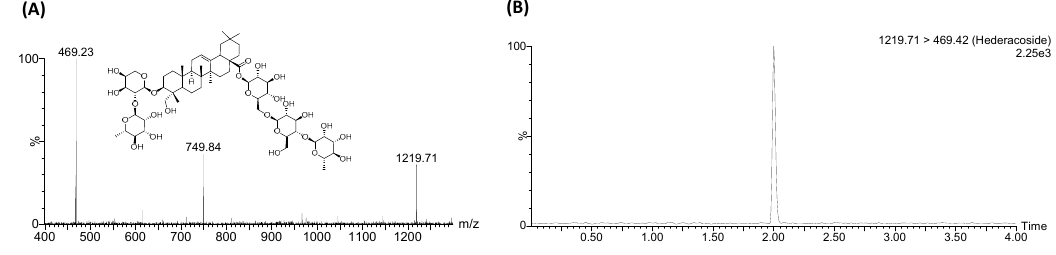
Figure 4. Hederacoside C, ( A ) product ion mass spectra of the [M − H] − ions of HDC, and ( B ) MRM chromatograms of HDC in H. helix extracts.